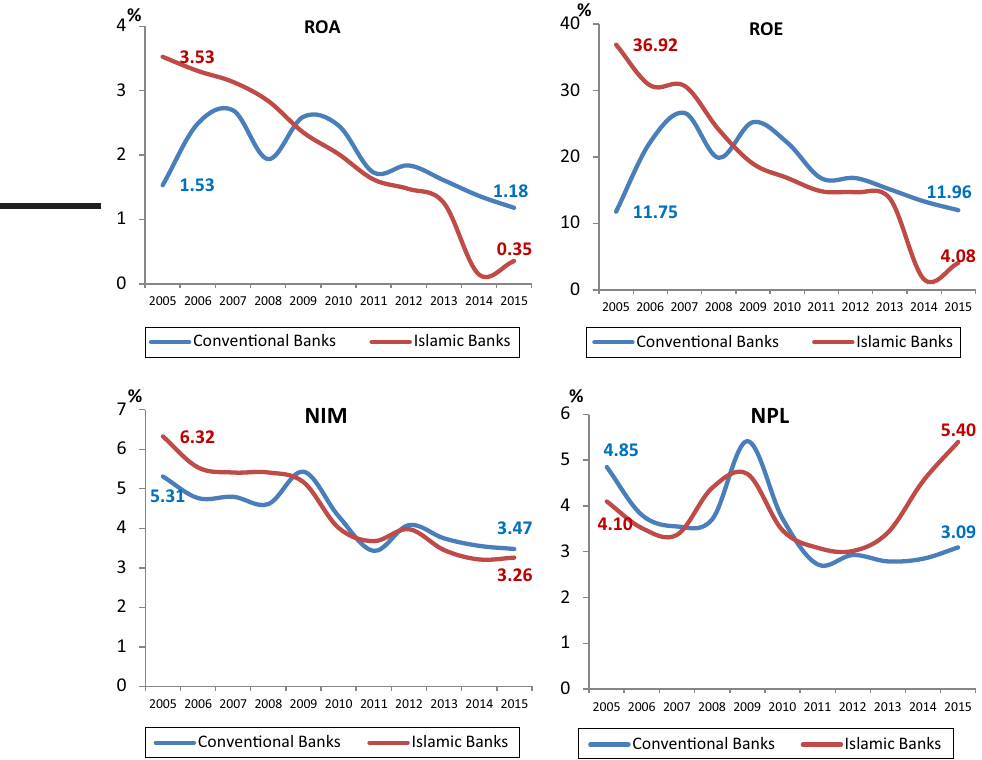
Figure 7. Key fi nancial